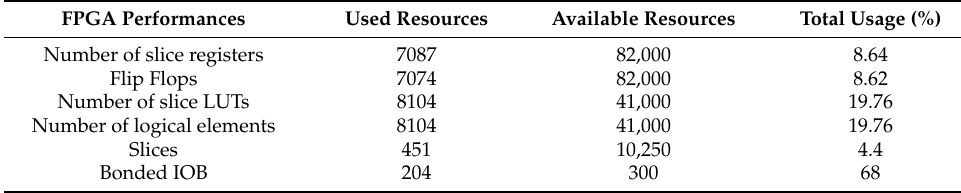
Table 5. Analysis of used resources for AES-FJMKE designed in Kintex 7 devices.